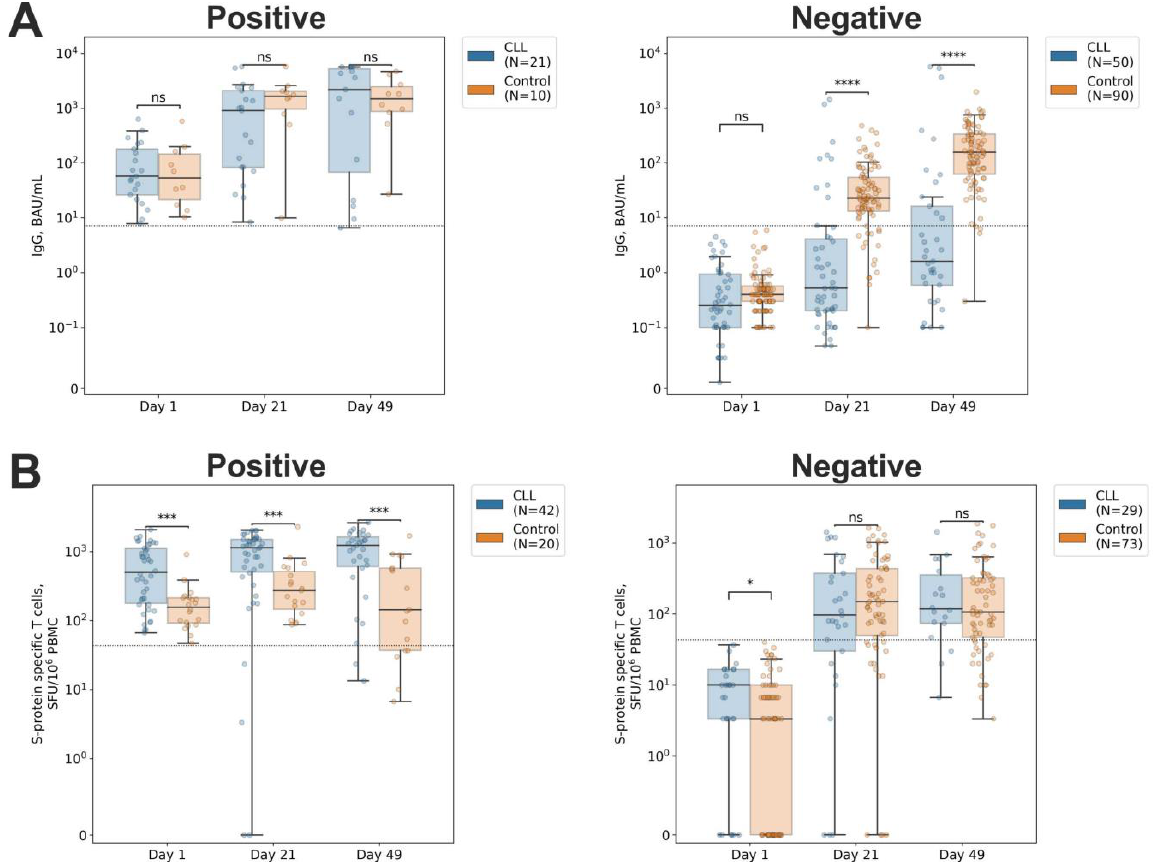
Figure 1. Dynamics of the SARS-CoV-2–specific antibody and T cell responses. Participants were split according to their positivity for the antibody ( A ) and T cell ( B ) responses. Immune responses were evaluated prior to the vaccination on day 1 (d1), prior to the administration of the second component on day 21 (d21), and 28 days after second component administration (d49). A symmetric logarithm (symlog) scale was used for the y -axis, with the range from 0 to the first axis tick being in linear scale, and the rest of the range in logarithmic scale. Dotted horizontal lines denote the positivity threshold. p -values > 5 × 10 2 are marked with ‘ns’; 1 × 10 2 < p -values ≤ 5 × 10 2 are marked with ‘ * ’; 1 × 10 4 < p -values ≤ 1 × 10 3 with ‘ *** ’; and p -values ≤ 1 × 10 4 with ‘ **** ’ (two-sided Mann–Whitney U